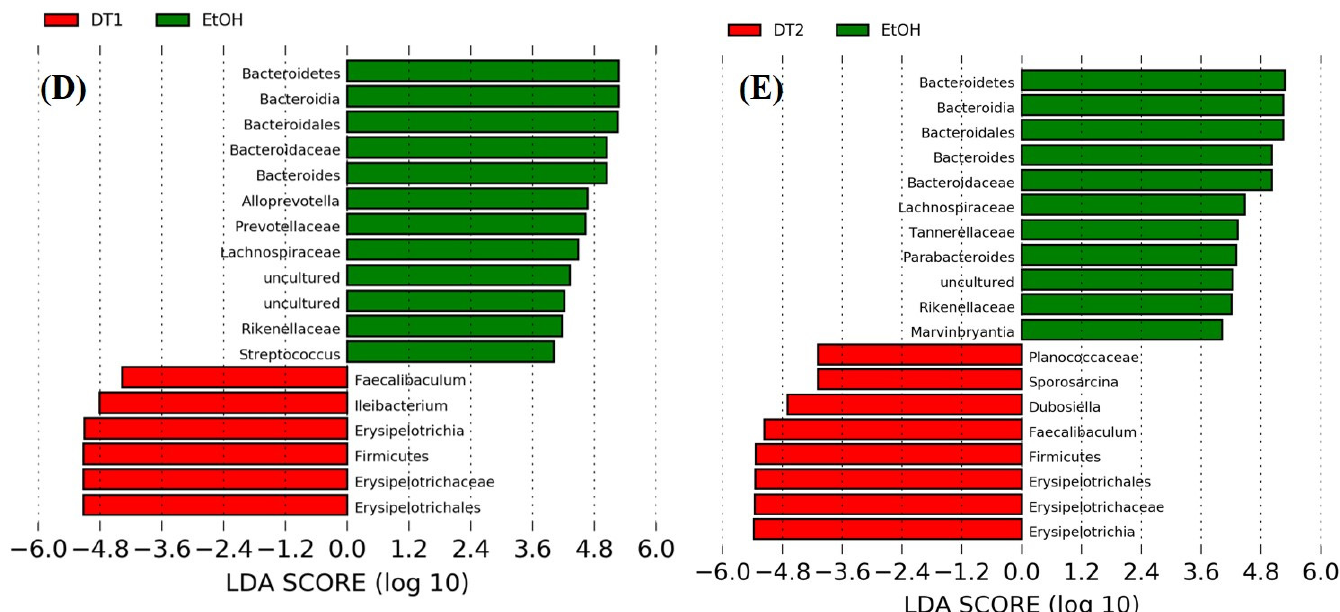
Figure 9. The LDA distribution chart generated from LEfSe showing the most differentially abundant taxa in intestinal microbiota ranging from phylum to genus (LDA score > 4). CTRL, the control group; EtOH, the model group; OT1, Tieguanyin Tea; OT2, Fenghuang Danzong Tea; DT1, Fu Brick Tea; DT2, Selenium-Enriched Dark Tea. ( A ) CTRL (red) + EtOH (green); ( B ) EtOH (red) + OT1 (green); ( C ) EtOH (red) + OT2 (green); ( D ) EtOH (green) + DT1(red); ( E ) EtOH (green) + (red) DT2.